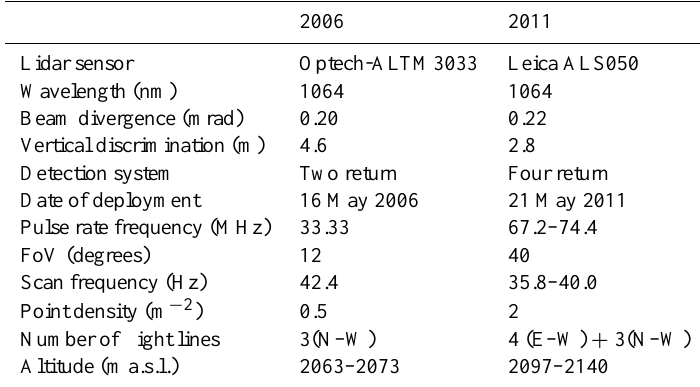
Table 1. Specifications for the lidar surveys undertaken at Alto Tajo (Spain) in 2006 and